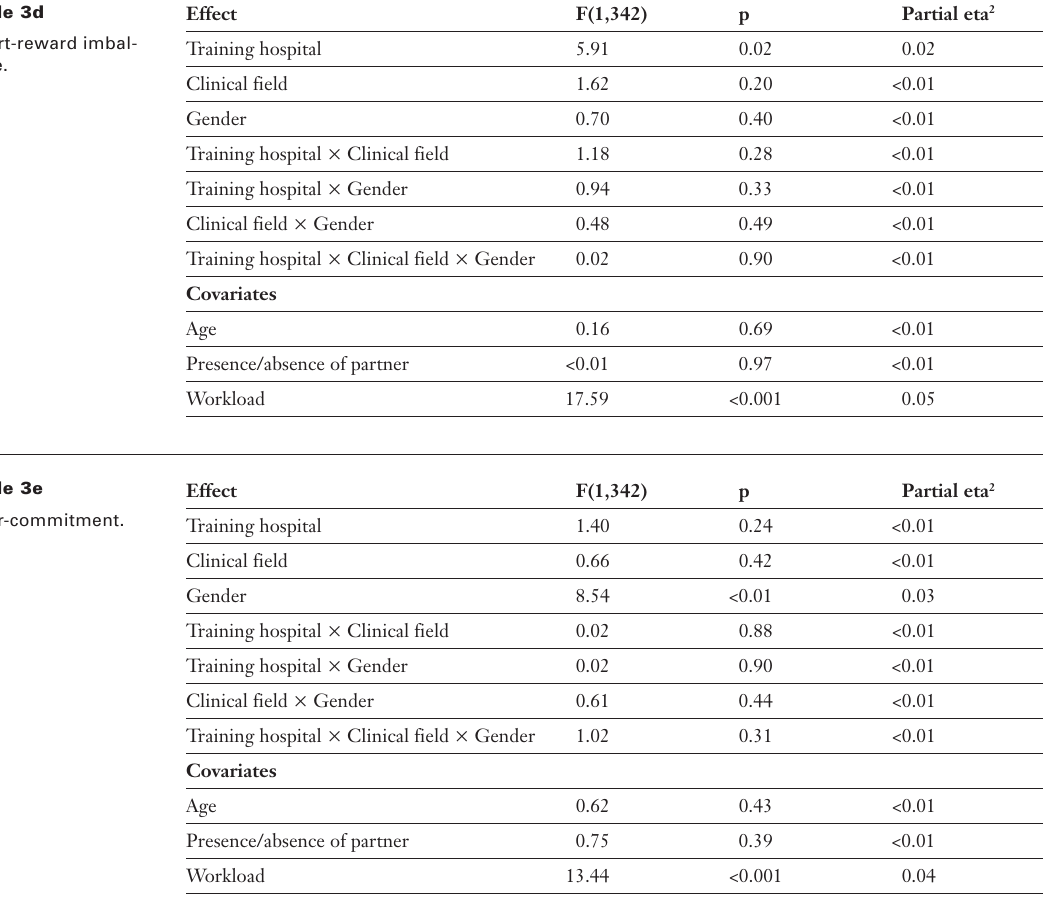
Effort-reward imbal- ance.